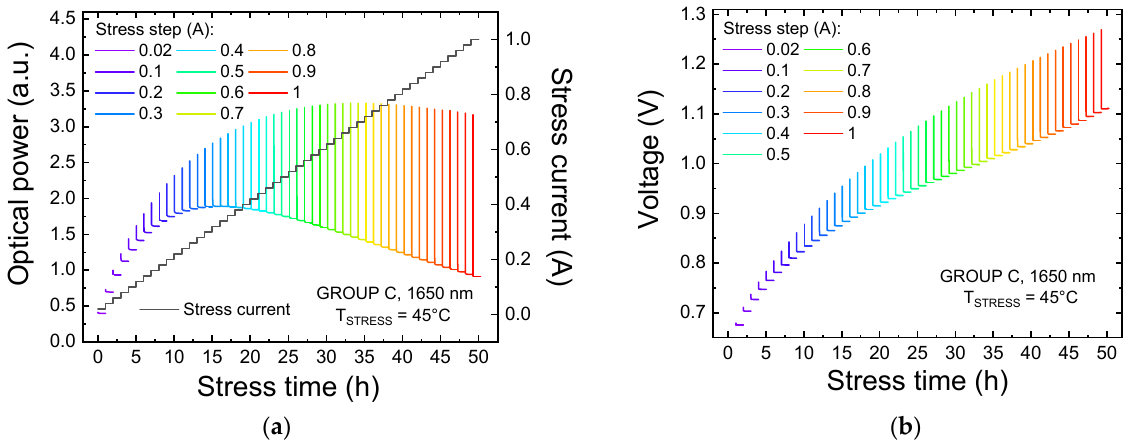
Figure 5. Variation of the optical power ( a ) and of the operating voltage ( b ) of an LED of group C submitted at the current step-stress procedure at T STRESS = 45 °C.